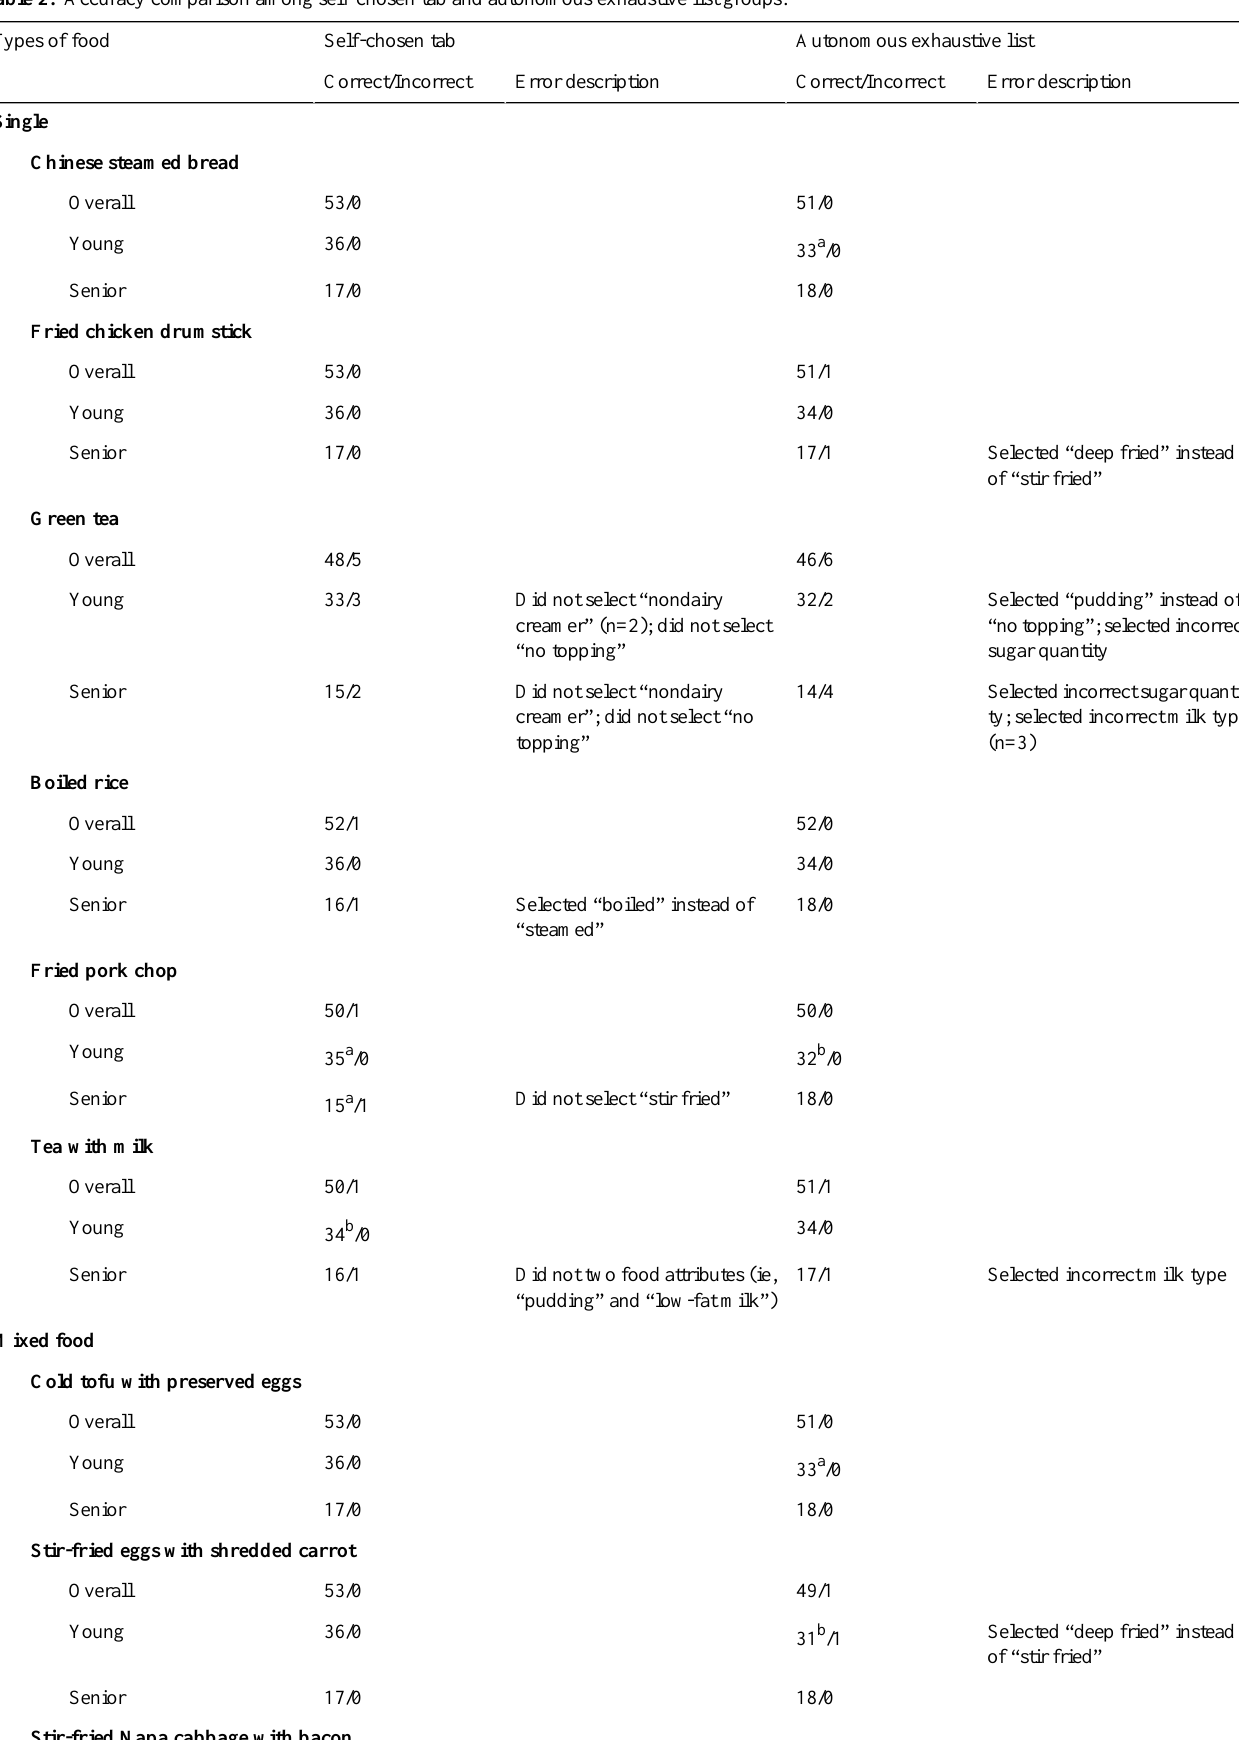
Table 2. Accuracy comparison among self-chosen tab and autonomous exhaustive list groups.